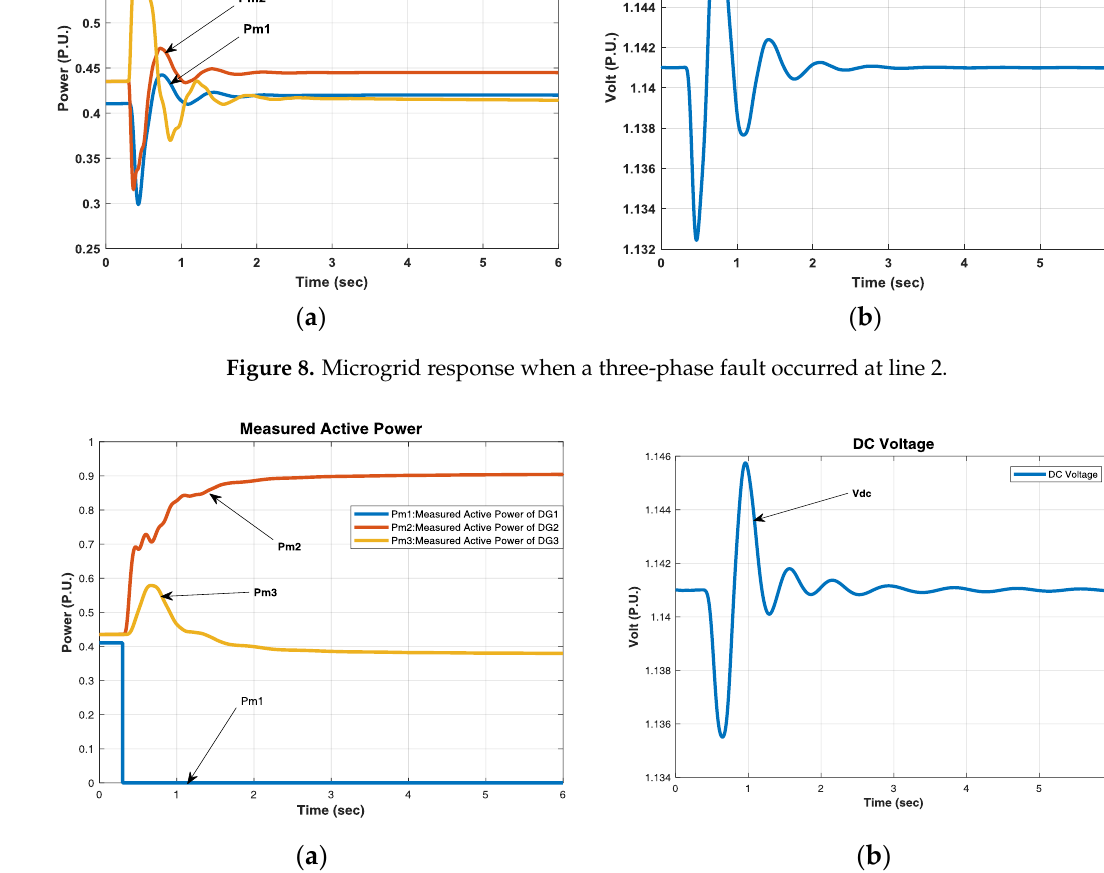
Figure 7. Microgrid response when a three-phase fault occurred at CPL bus.